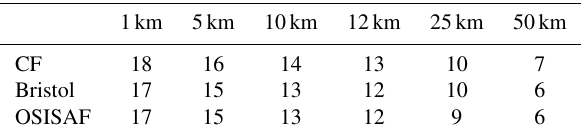
Table 2. The SD of the difference between the simulated SSM/I– SSMIS satellite ice concentration and the reference ice concentra- tion resampled to different grid resolutions in percent.